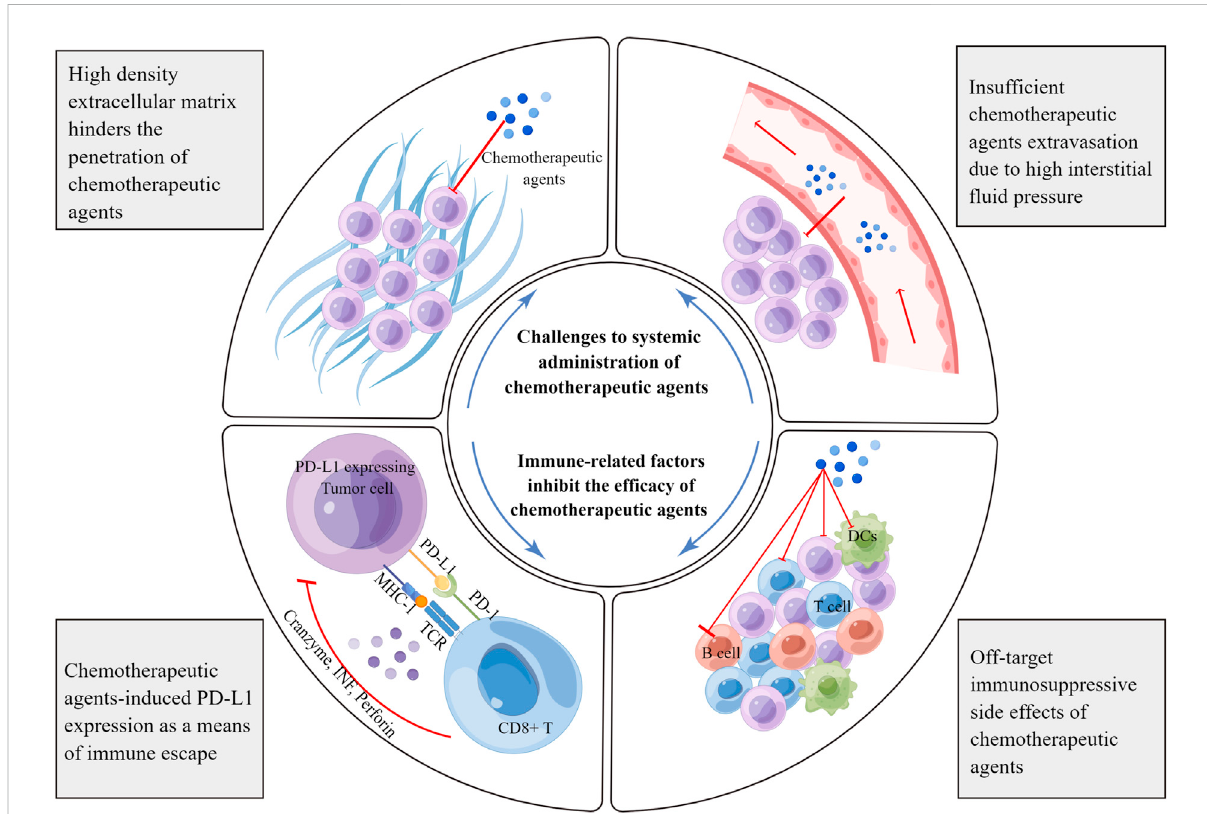
FIGURE 2 Limiting factors affecting the immunoregulatory effects of chemotherapeutic agents. Chemotherapeutic agents can induce the expression of negativeimmunecheckpoints,especiallyPD-L1.PD-L1associateswiththePD-1receptoroneffectorTcells,bluntinganti-tumorimmuneresponses and facilitating immune escape. Furthermore, chemotherapeutic agents target rapidly proliferating immune cells, resulting in off-target side effects. Thedensenetworkoftheextracellularmatrixhindersthespreadofchemotherapeuticagentsintumors.Inaddition,thereishighinterstitial fl uid pressure in tumor tissues, which prevents the extravasation of chemotherapeutic agents from the blood vessels. MHC, major histocompatibility complex; TCR, T cell receptor; TNF, tumor necrosis factor; DC, dendritic